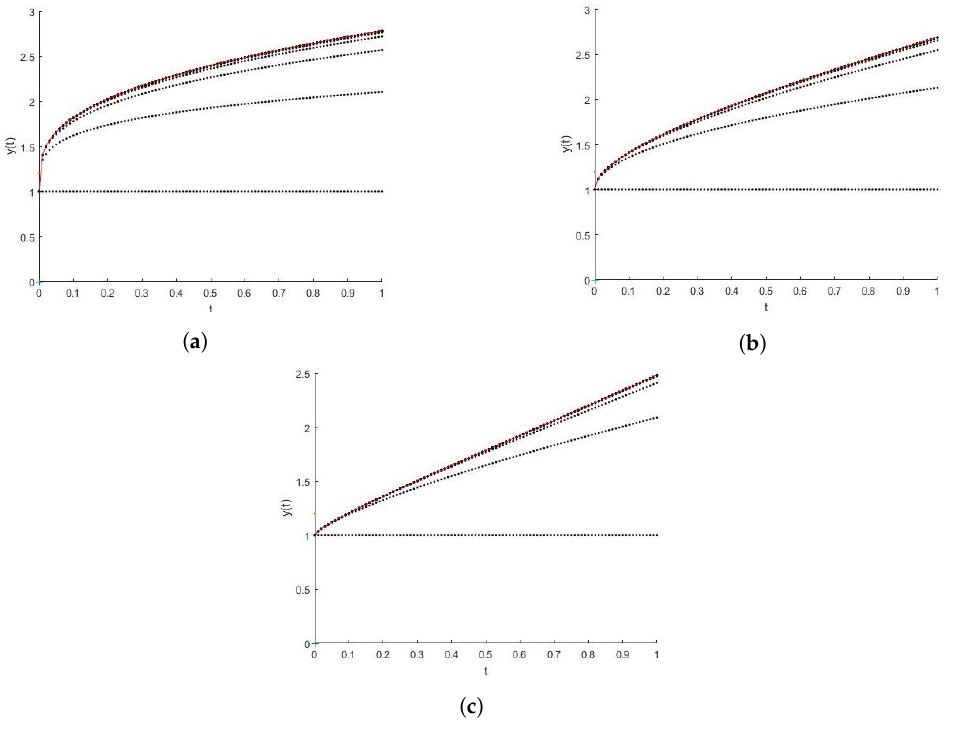
Figure 2. Graphs of c D q u = u .5 , u ( 0 ) = 1 from t = 0 to t = 1. ( a ) Graph of c D .25 u = u .5 , u ( 0 ) = 1. ( b ) Graph of c D .5 u = u .5 , u ( 0 ) = 1. ( c ) Graph of c D .75 u = u .5 , u ( 0 ) =